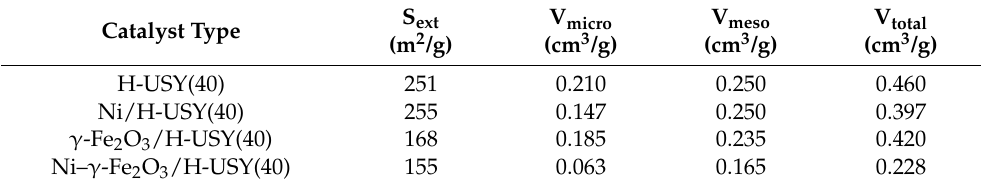
Table 2. Textural properties determined by N 2 adsorption/desorption for parent H-USY(40) and MNP-based zeolites.